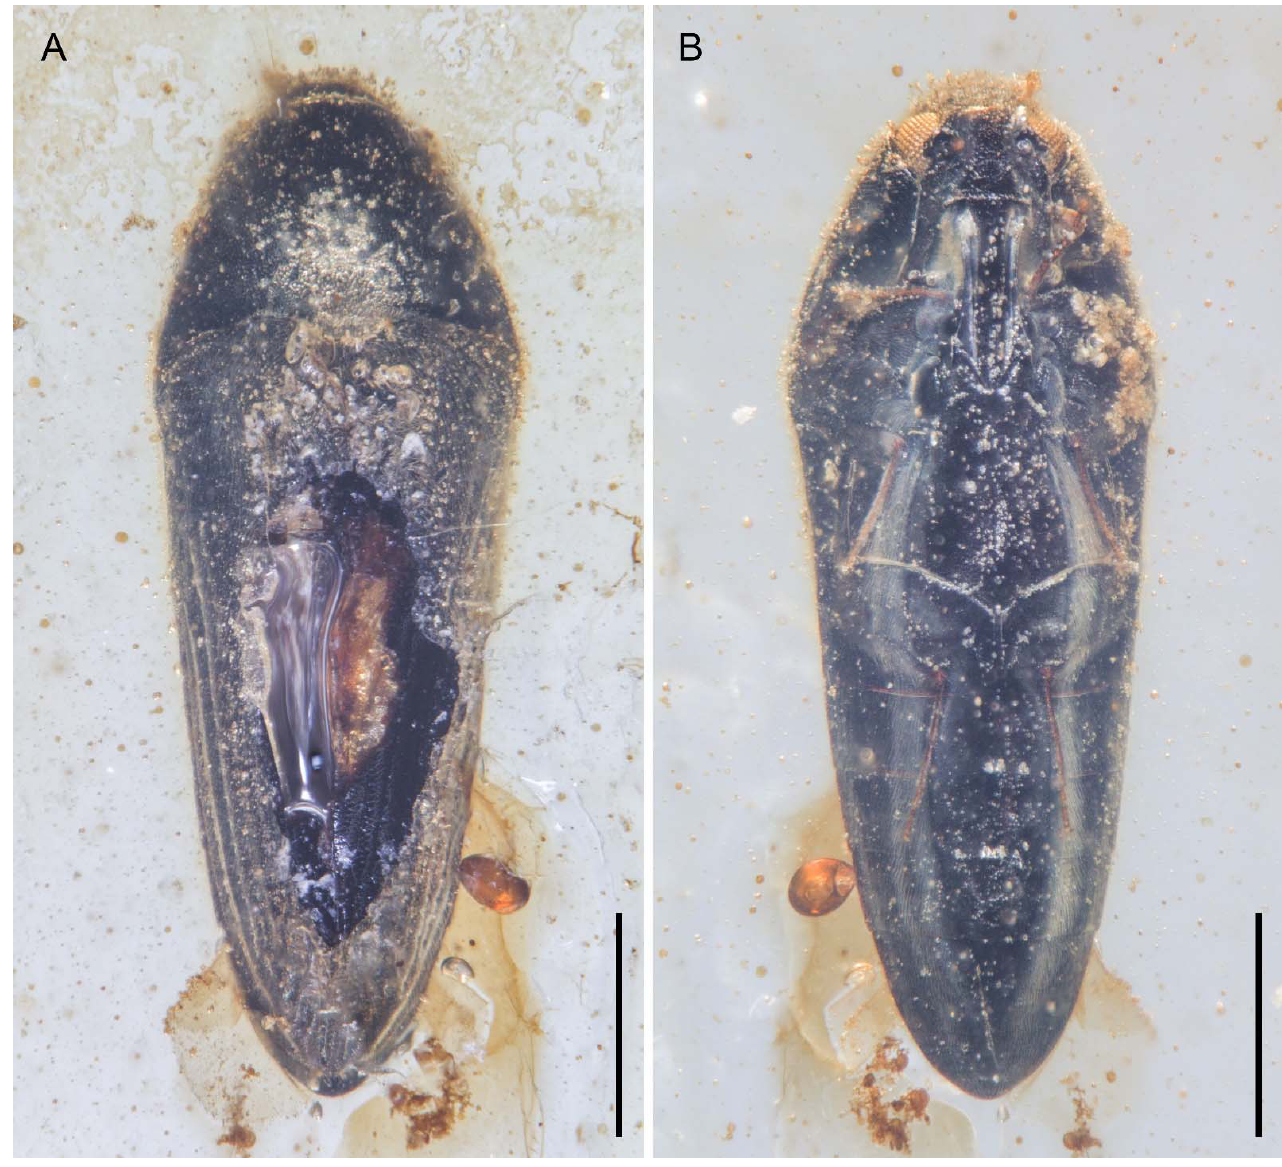
Figure 4. General habitus of Electrothroscus yanpingae gen. et sp. nov. , holotype, NIGP173916, under incident light. ( A ) Dorsal view. ( B ) Ventral view. Scale bars: 500 μ m.